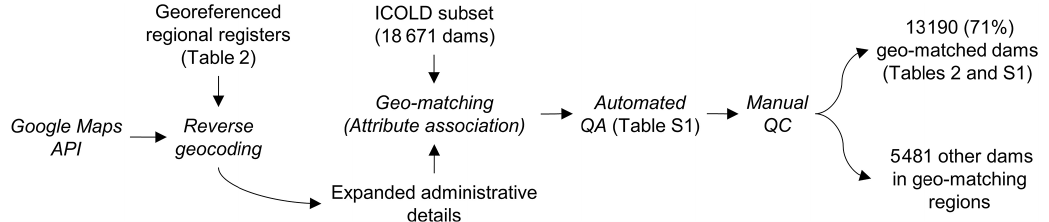
Figure 3. Schematic procedure of geo-matching regional registers. Text in roman indicates applied or produced datasets, and text in italics indicates methods or